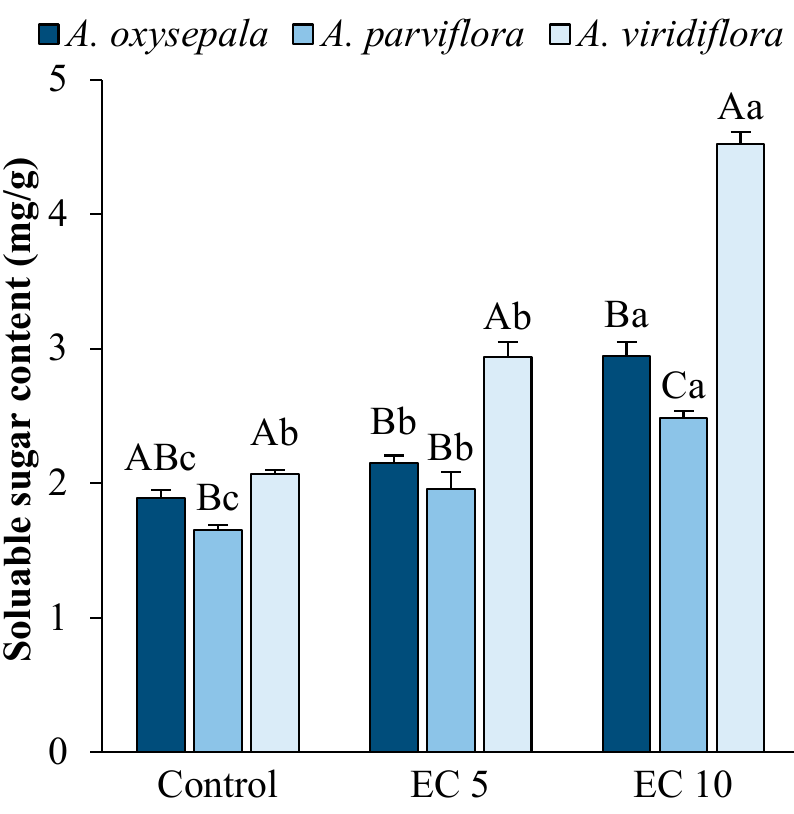
Figure 7. Soluble sugar content of A. oxysepala , A. parviflora , and A. viridiflora irrigated with tap water (control) and salt solution at an electrical conductivity (EC) of 5 dS · m − 1 (EC 5) and 10 dS · m − 1 (EC 10). According to Tukey’s variance and analysis at p < 0.05, means with the same uppercase letters are not significantly changed among different species under the same treatment, and means with the same lowercase letters are not significantly changed among different treatments in the same species. Vertical bars represent standard error